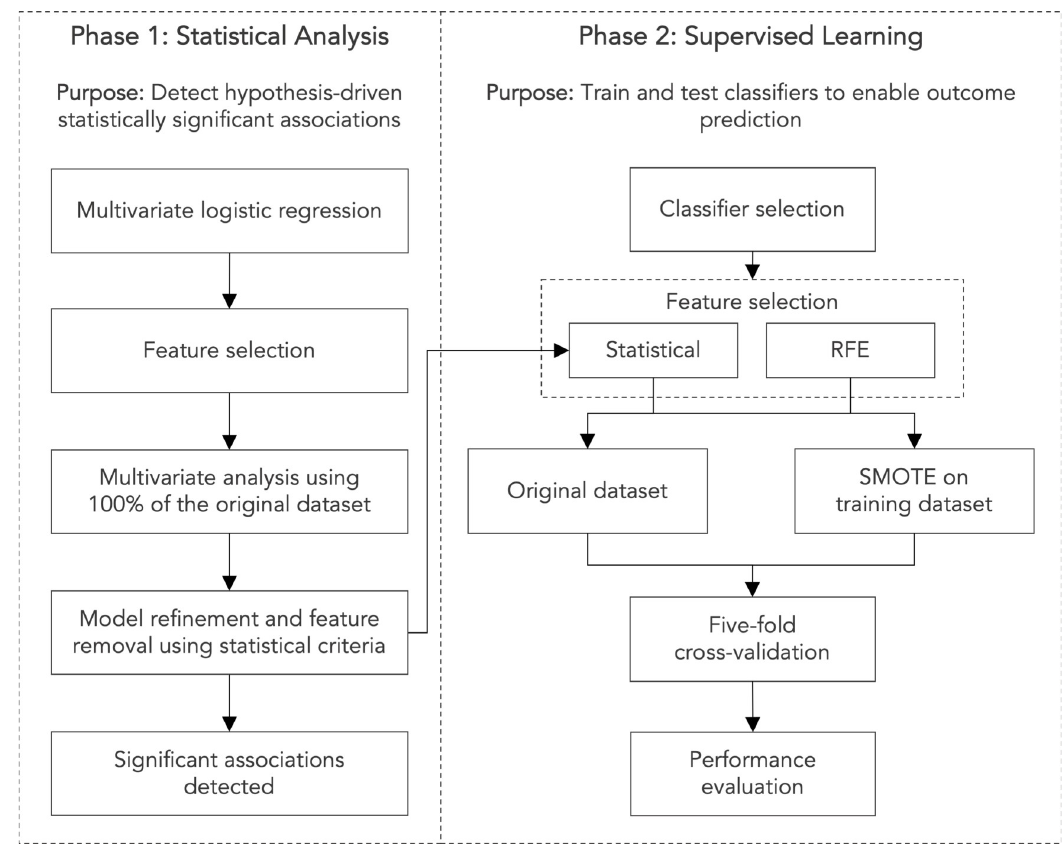
Fig 1. Methodology overview. RFE, recursive feature elimination. SMOTE, synthetic minority oversampling technique.